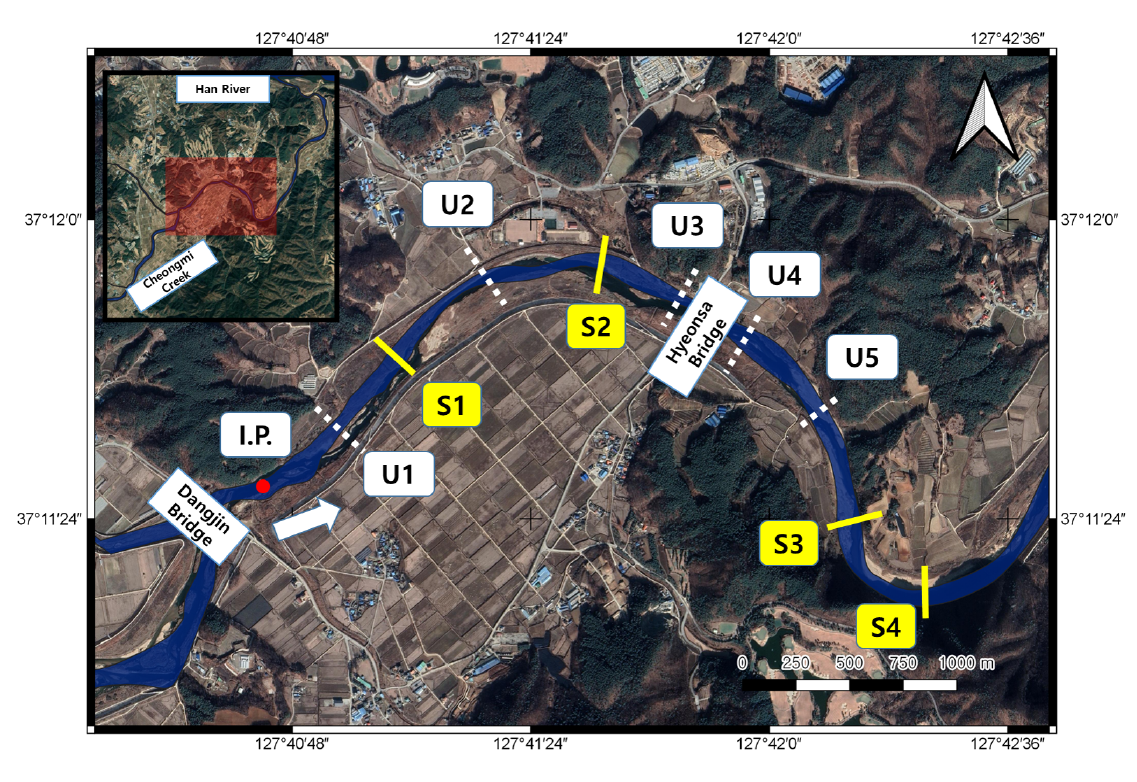
Figure 13. Plan view of the Cheongmi Creek test site.